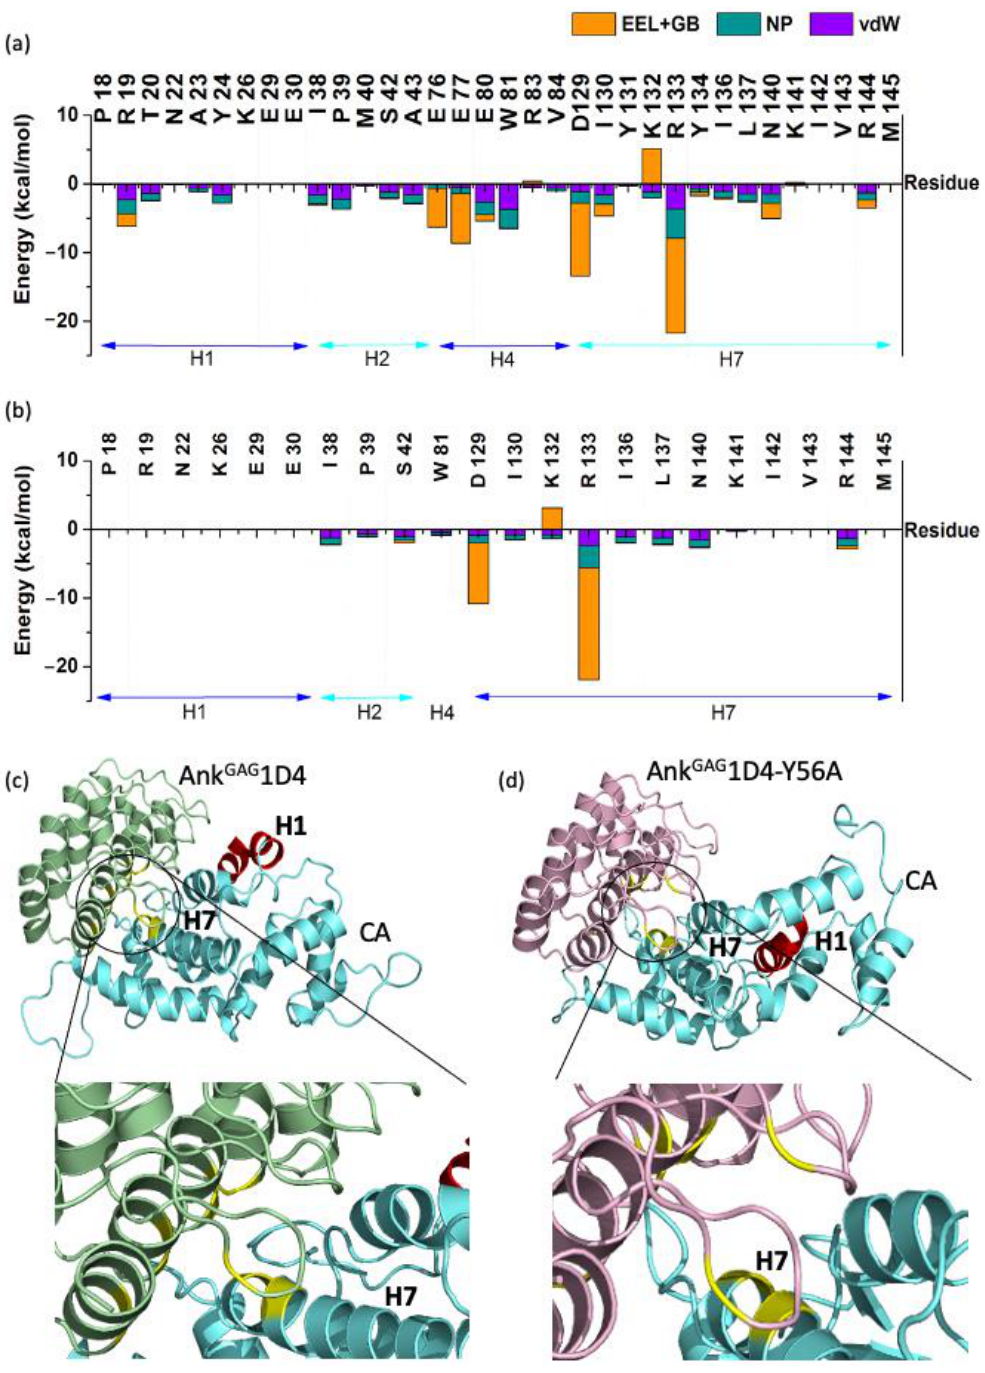
Figure 2. Interaction free energy of the CA residues interacting with ( a ) Ank GAG 1D4 and ( b ) Ank GAG 1D4- Y56A within 4 Å binding vicinity. Comparison between the conformation of ( c ) Ank GAG 1D4-CA and ( d ) Ank GAG 1D4-Y56-CA complexes after 100 ns simulations showed that the H1 (red) moved further away from the DARPin in (d). Residues in both complexes that contributed the most in the binding free energy were highlighted in yellow.